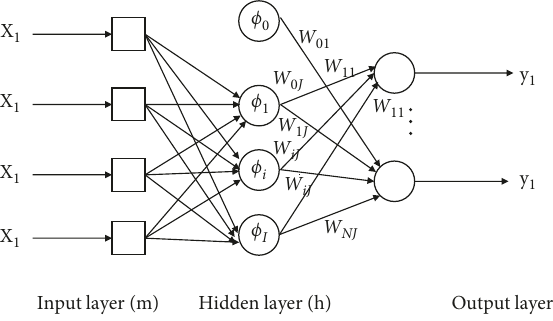
Figure 1: Structure of a generalized RBF neural